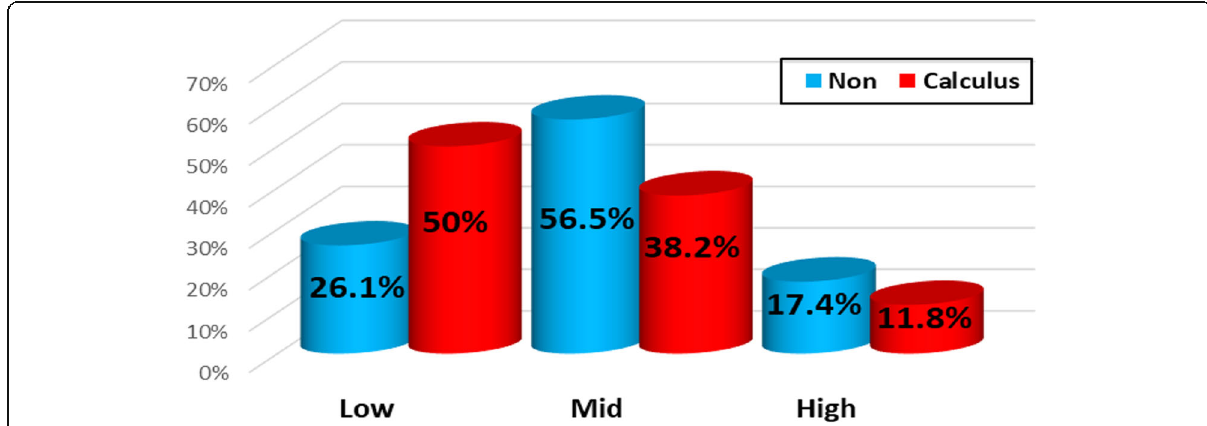
Fig. 6 Severity of acute pancreatitis according to the cause